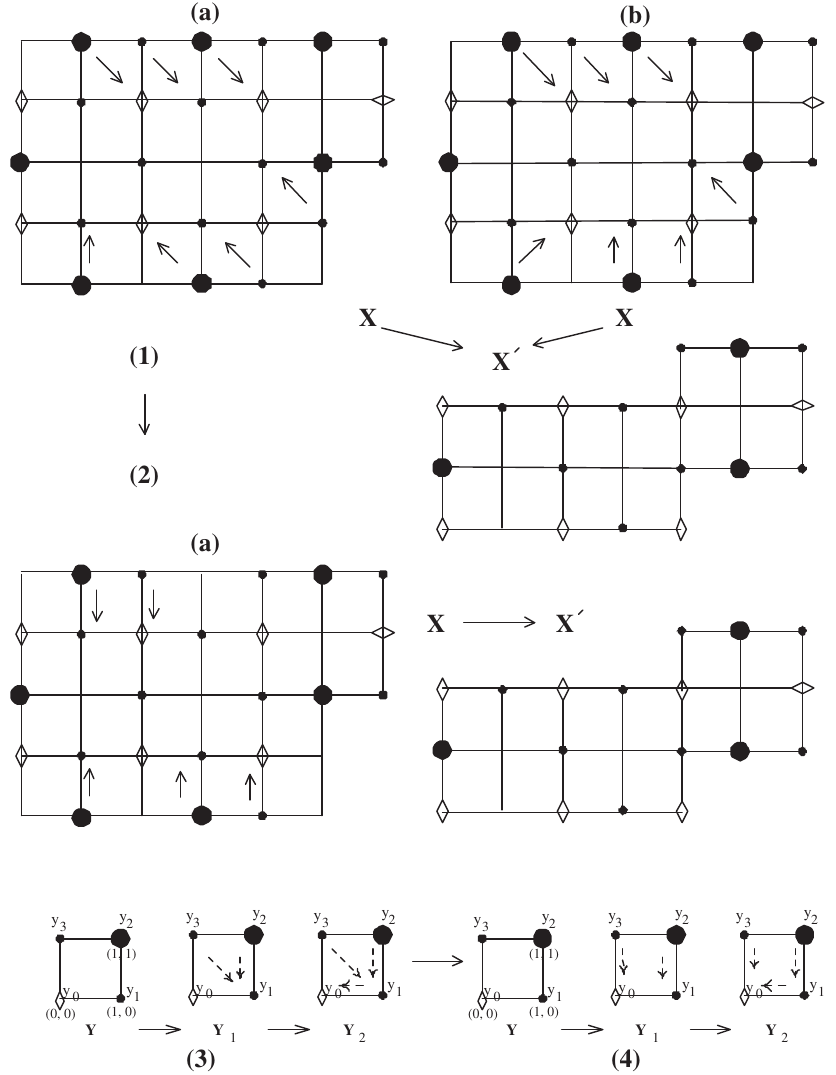
Figure 2. Some corrections of the picture of Figure 4 of [11] and the picture of Figure 2 of